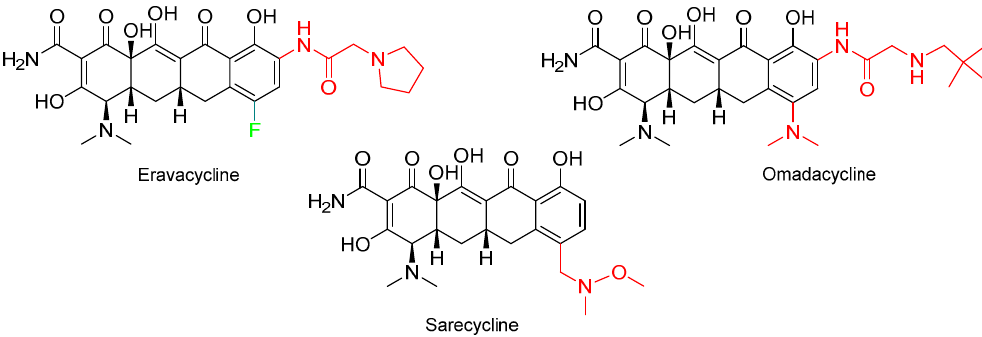
Figure 4. Structures of tetracycline drugs. In red the variable part.